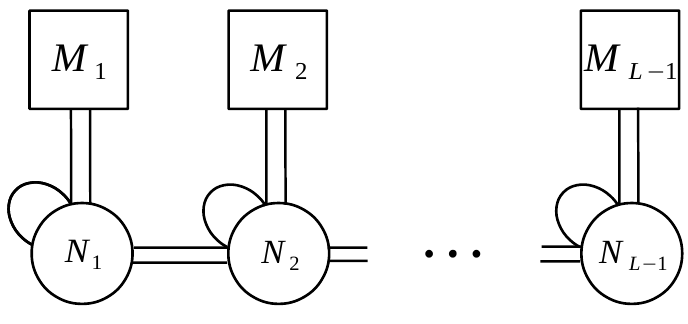
Figure 2 . The T (cid:27) [SU( N )] quiver. Ranks N i ; M i are as in eq. (cid:26)